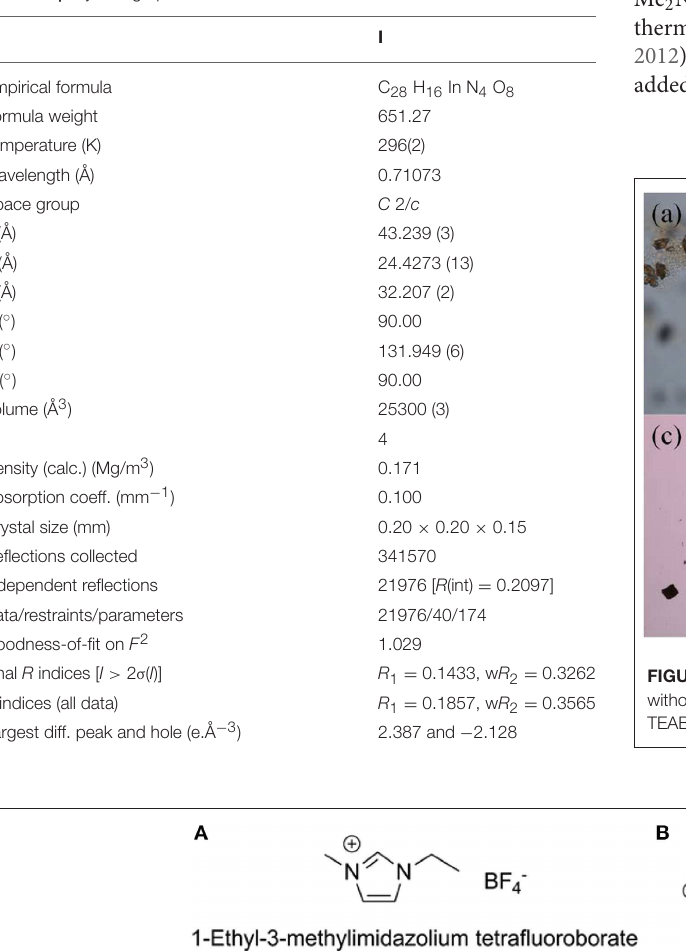
TABLE 1 | Crystallographic data for I .